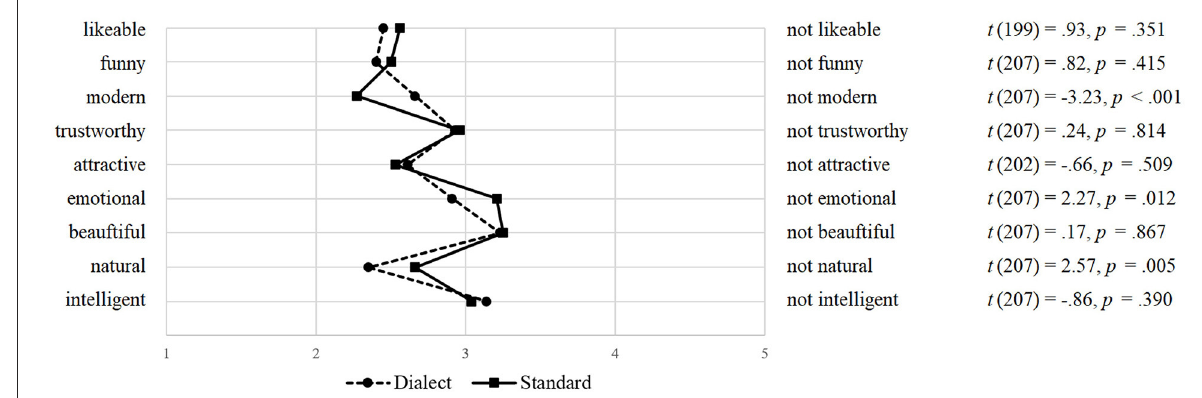
FIGURE3 Results for the perception of the language in the presented image macros in study I.